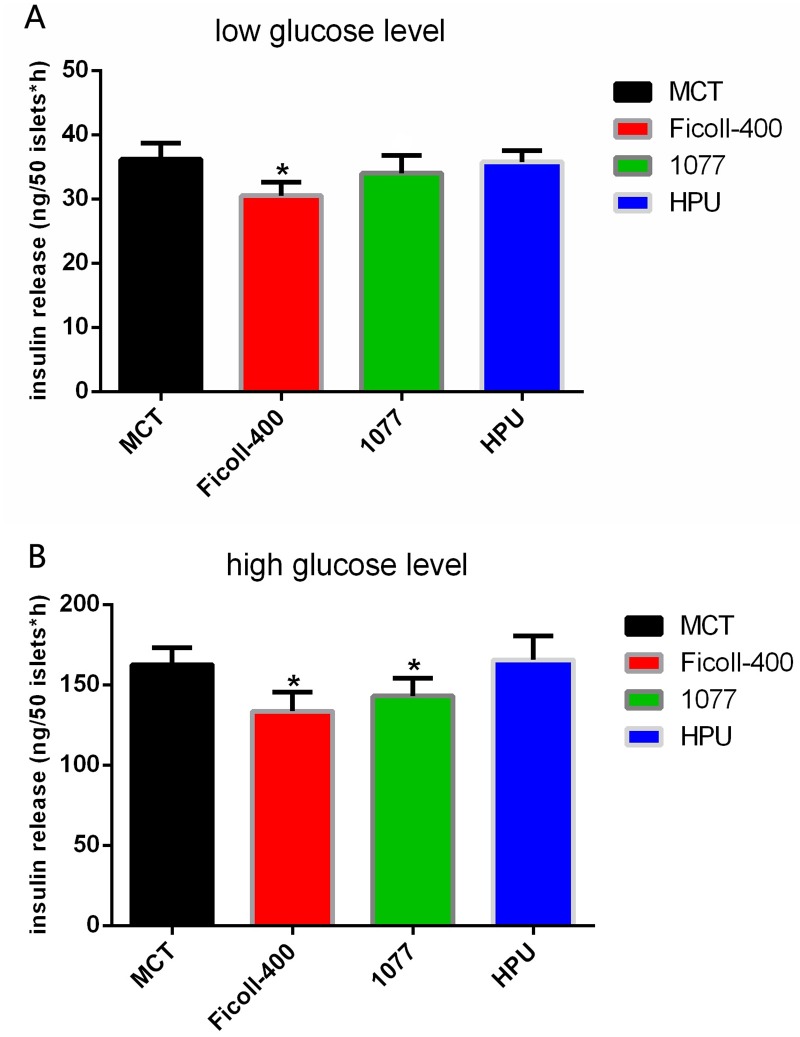
Insulin secretion stimulated by different glucose levels in each group.